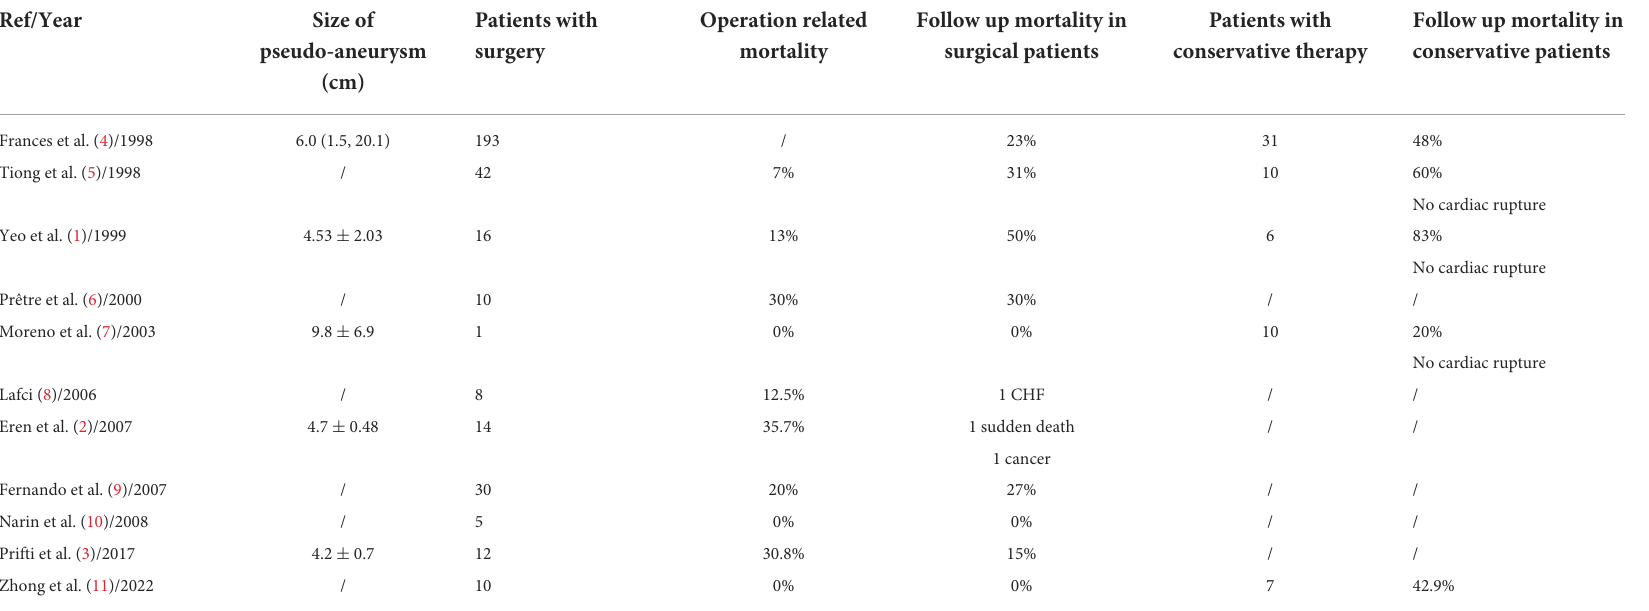
TABLE 1 Summary of clinical investigations about LV